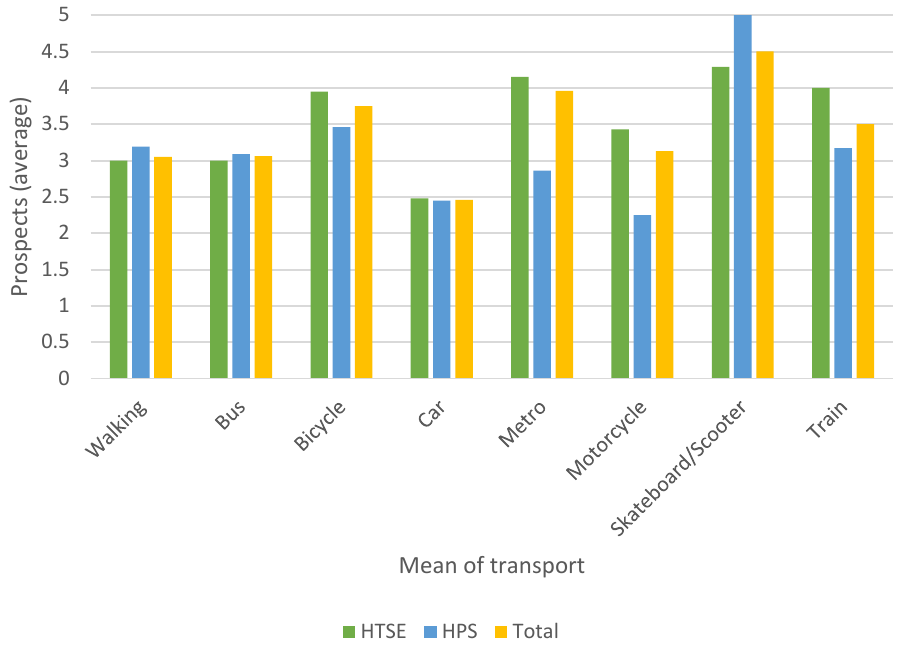
Figure 5. Average of prospects of the selected mode of transport (Q16).